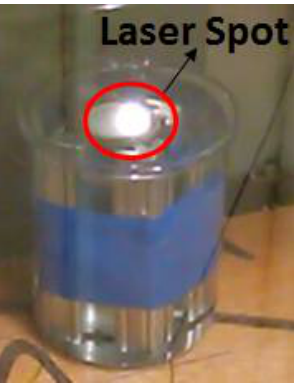
Figure 5. Irradiated laser spot on the substrate surface during LA-LBMM process.